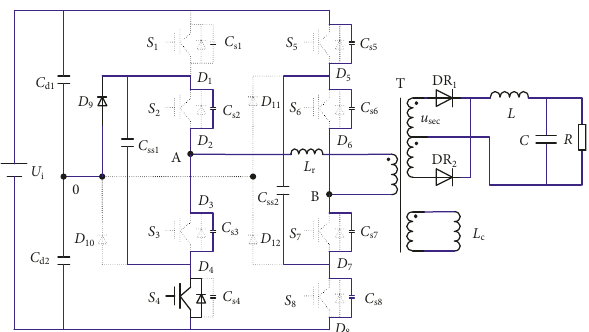
Figure 12: Equivalent circuit of mode 4.